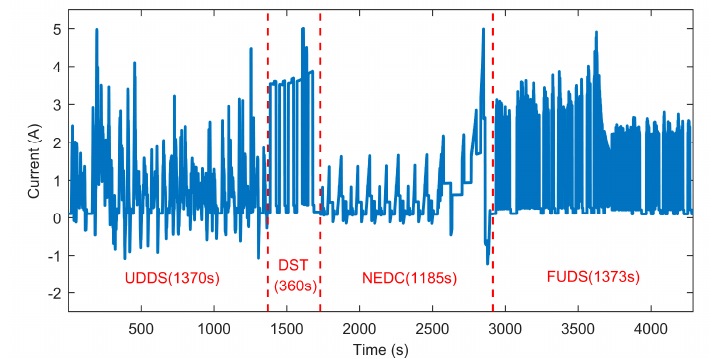
Figure 6. Current profile in a cycle.